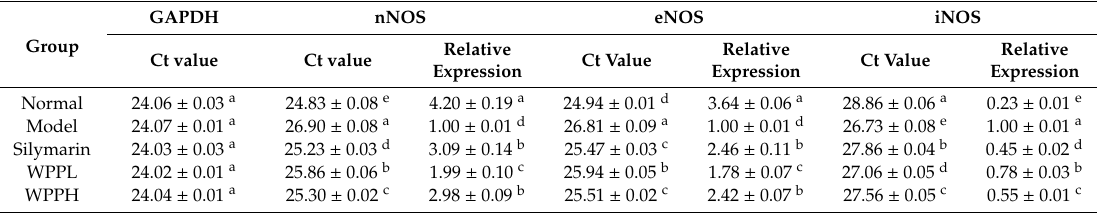
Relative Relative Relative Ct Value Ct Value Expression Expression Expression